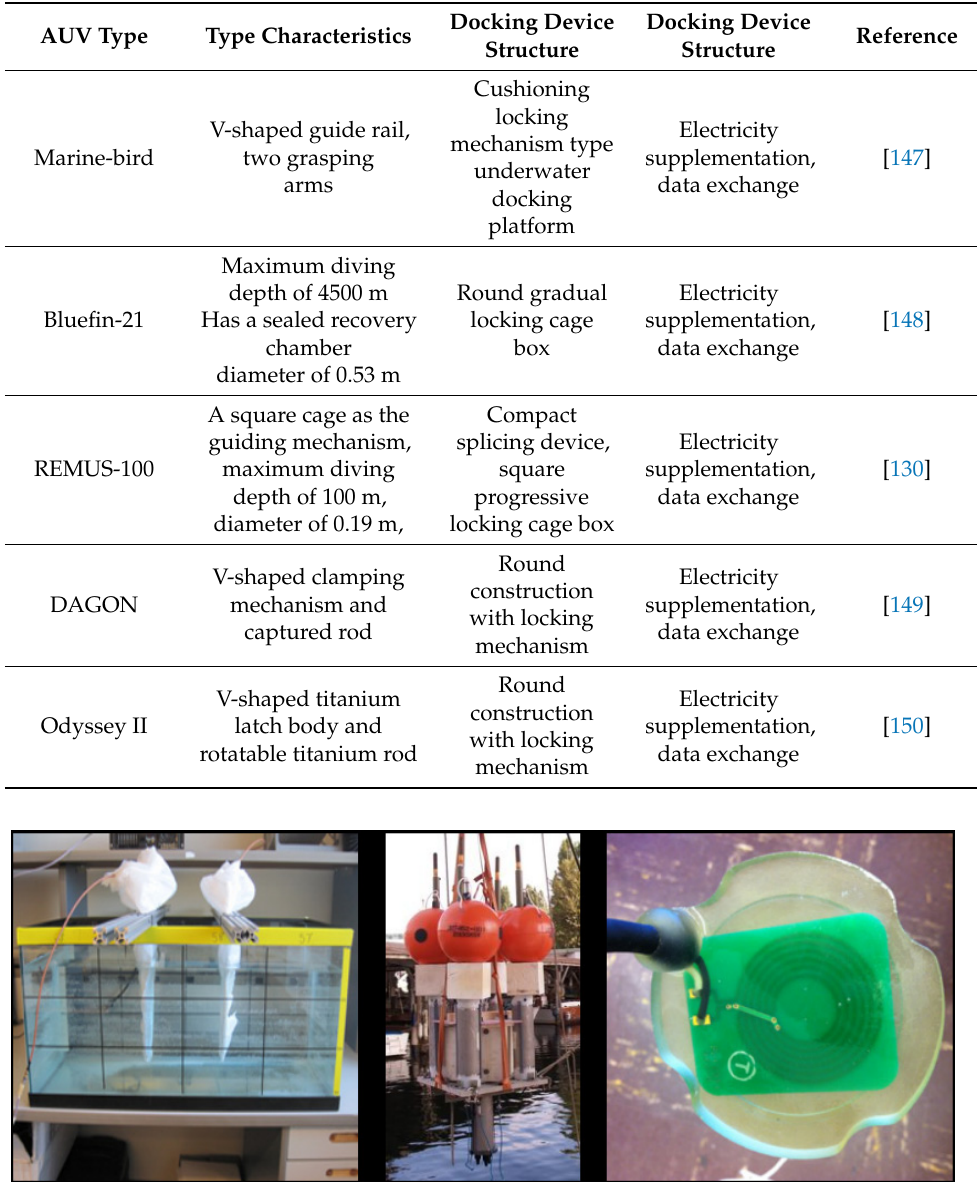
Table 8. Comparison of existing docking stations [123].